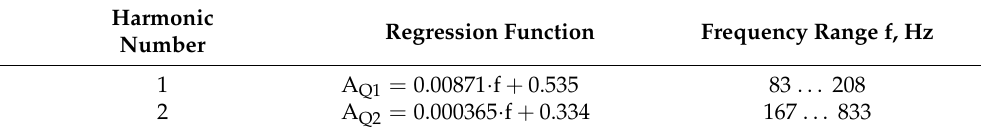
Table 4. Regression functions of the flow pulsation amplitudes in the experiment with a “short” pipeline. Harmonic Regression Function Number